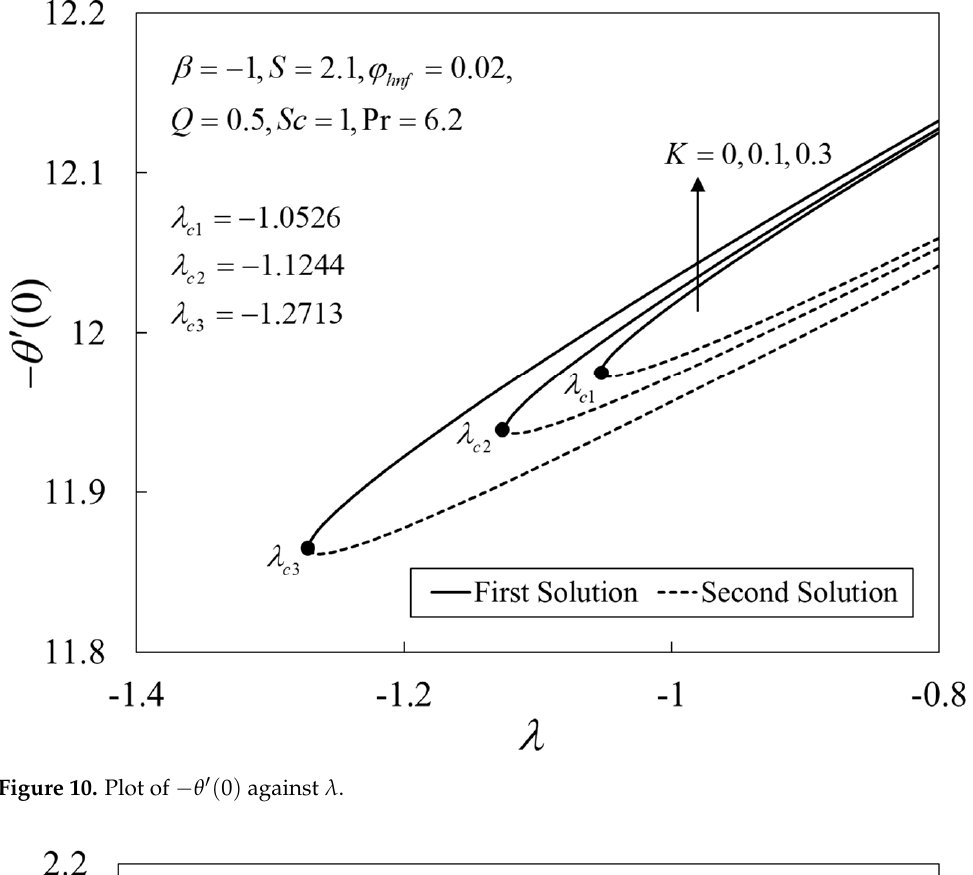
Figure 9. Plot of (0) f  against  .